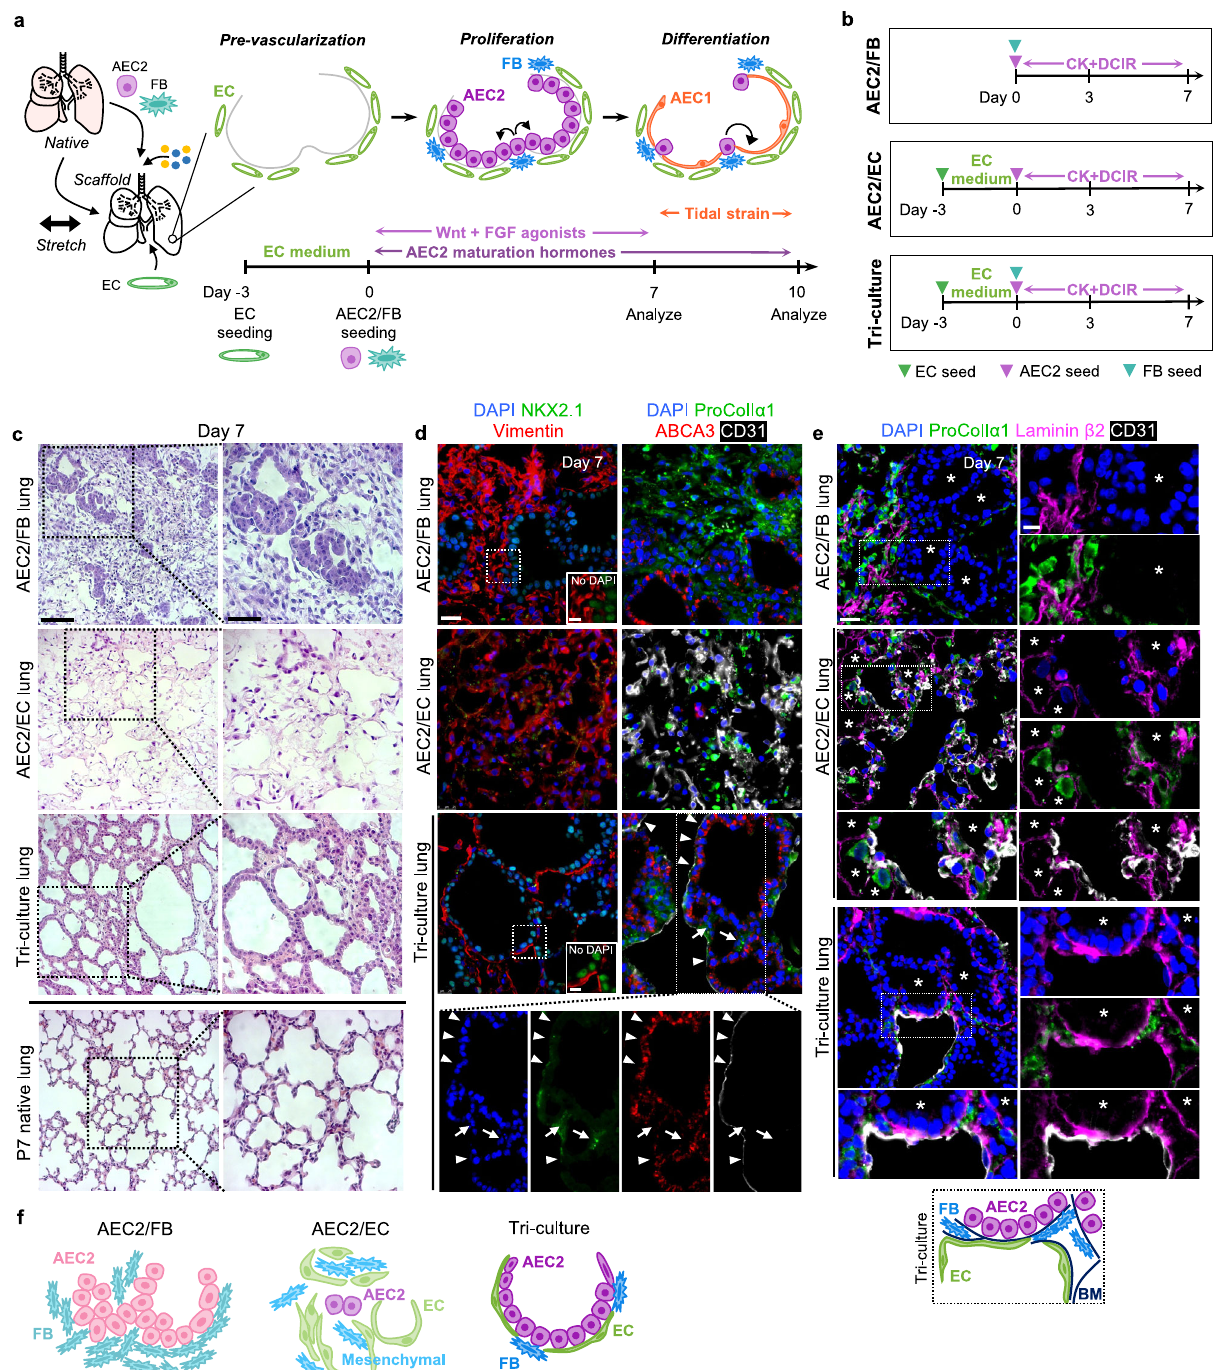
Fig. 1 Fibroblast-endothelial co-culture promotes lung scaffold repopulation with AEC2s in organized alveolar-like structures. a Schema for alveolar epithelial engineering via modulation of niche cues, with hypothesized timeline of lung recellularization with AEC2s and AEC1s. Timeline corresponds to the pre-vascularization, proliferation, and differentiation phases illustrated at the top of the panel. b Timelines for engineered whole lung co-cultures. c H&E staining of engineered lung cultures and P7 native lung. Scale bars: main image, 100 μ m. Magni fi ed region, 50 μ m. d Immunostaining showing distribution of NKX2.1 + epithelial cells and vimentin + mesenchymal cells (FBs and/or ECs) (left); or ABCA3 + AEC2s, ProColI α 1 + FBs, and CD31 + ECs (right) in engineered lungs. Arrowheads, CD31 + ECs. Arrows, ProColl1 α 1 + FBs. Scale bar, 25 μ m; insets, 10 μ m. In images on right, adjustments to contrast of individual color channels were performed identically across all samples. e Immunostaining showing localization of ProColI α 1 + FBs and CD31 + ECs relative to basement membrane (BM) component laminin β 2 in engineered lungs. Tri-culture cellular and BM organization is schematized below. Asterisks, luminal spaces. Scale bar, 25 μ m; insets, 10 μ m. f Schematics of alveolar repopulation in AEC2/FB, AEC2/EC, and tri-culture lungs at day